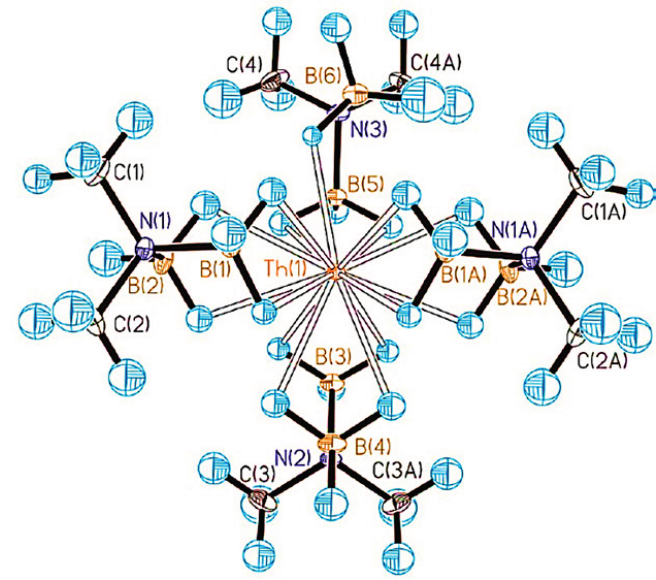
Figure 12. Molecular structure of [Th(H Ellipsoids are drawn at the 20% probability level. Th orange, B tan, N purple, C black, H